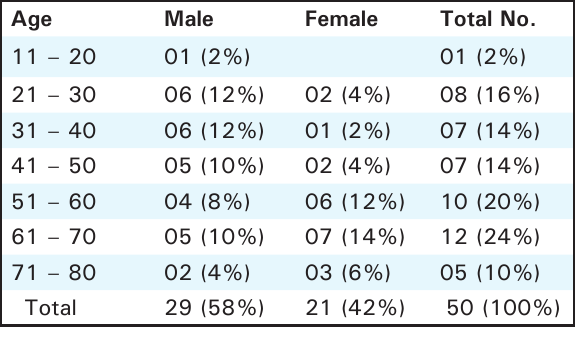
Table 1. Distribution of colorectal carcinoma according to age group.